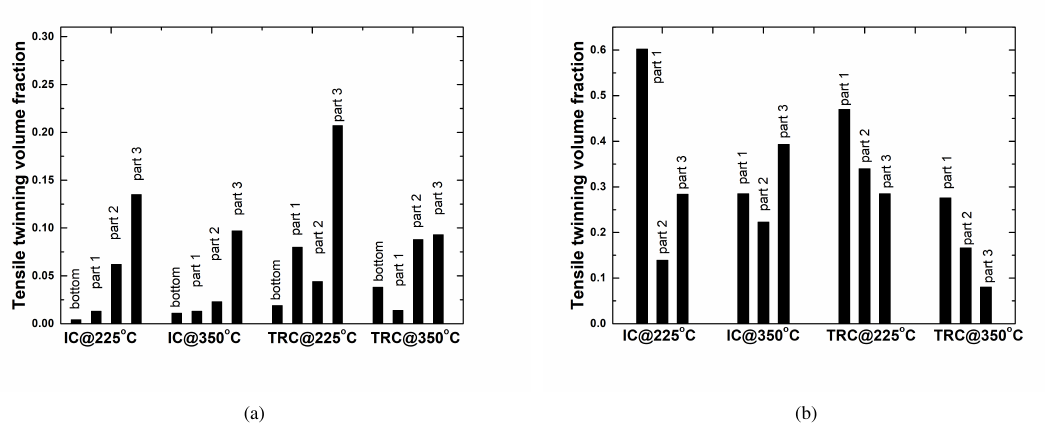
Figure 16. Volume fractions of tensile twin boundaries at each position of drawn cups, according to deformation rates of ( a ) 30 mm/min, and ( b ) 50 mm/min.